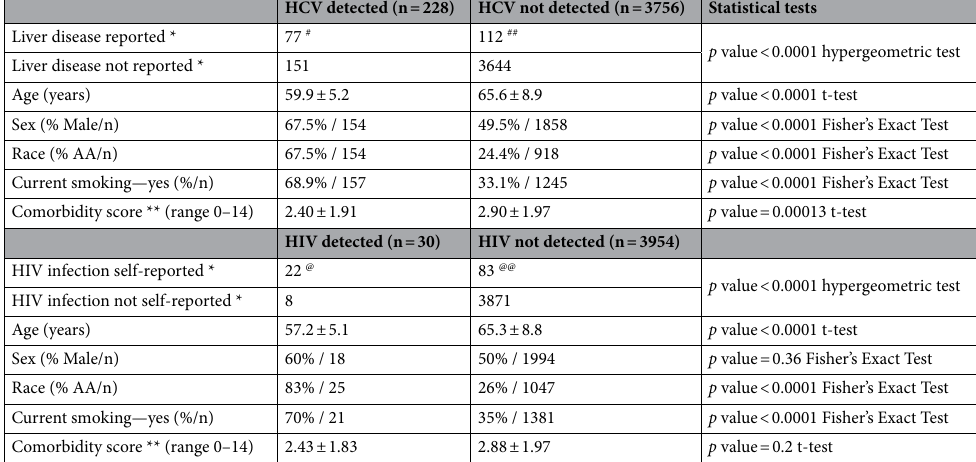
Table 1. Demographics of subjects with and without detected levels of peripheral blood Hepatitis C virus (HCV) or HIV RNA. # 68 at 5-year follow-up and 9 at 10-year follow-up. ## 103 at 5-year follow-up and 9 at 10-year follow-up. @ 15 at 5-year follow-up. @@ 47 at 5-year follow-up. *At any visit in the COPDGene study. **Sum of comorbidities reported, considering Coronary Heart disease, Diabetes, Congestive heart failure, Stroke, Osteoarthritis, Osteoporosis, Hypertension, High cholesterol, Gastroesophageal reflux disease, Stomach ulcers, Obesity, Sleep apnea, Hay fever, Peripheral Vascular Disease 30